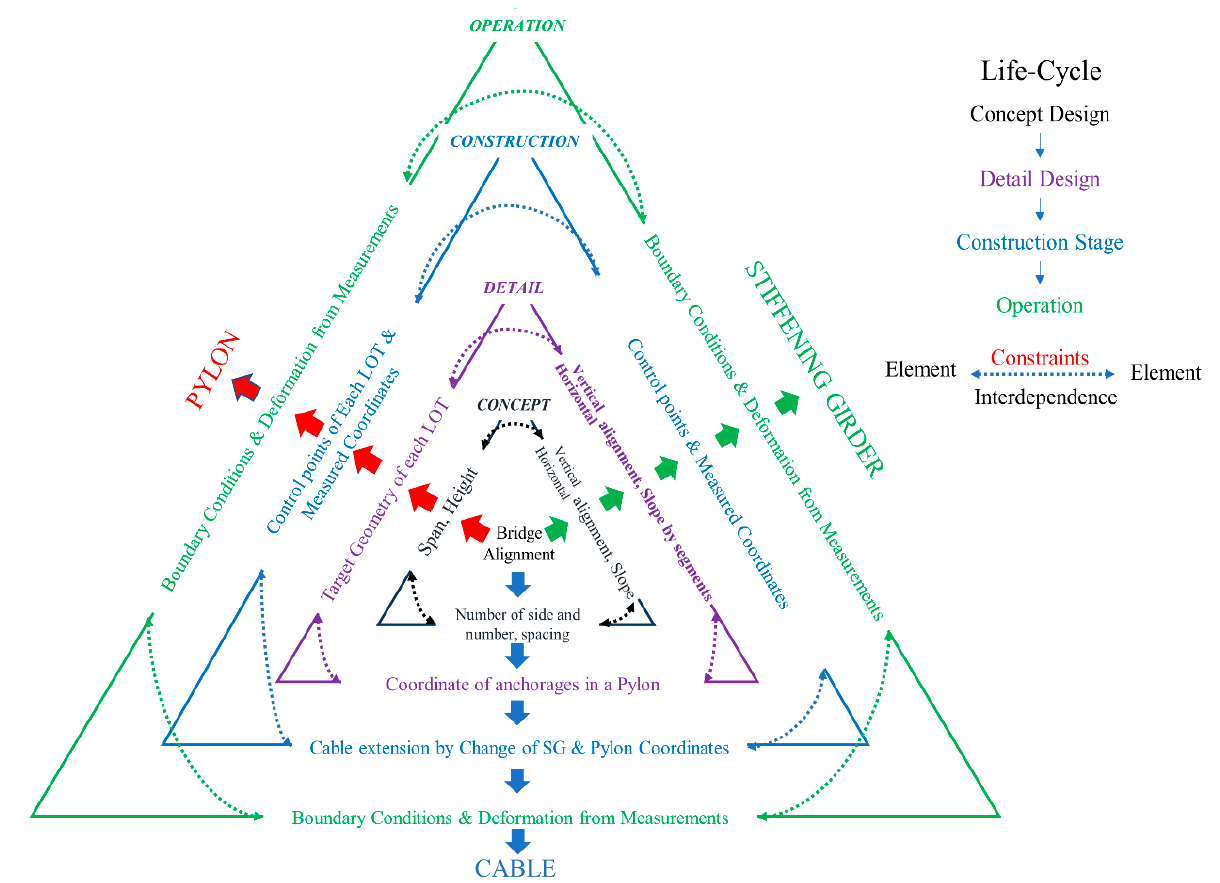
Figure 3. Positioning elements of the main members of the cable-stayed bridge based on the life cycle.